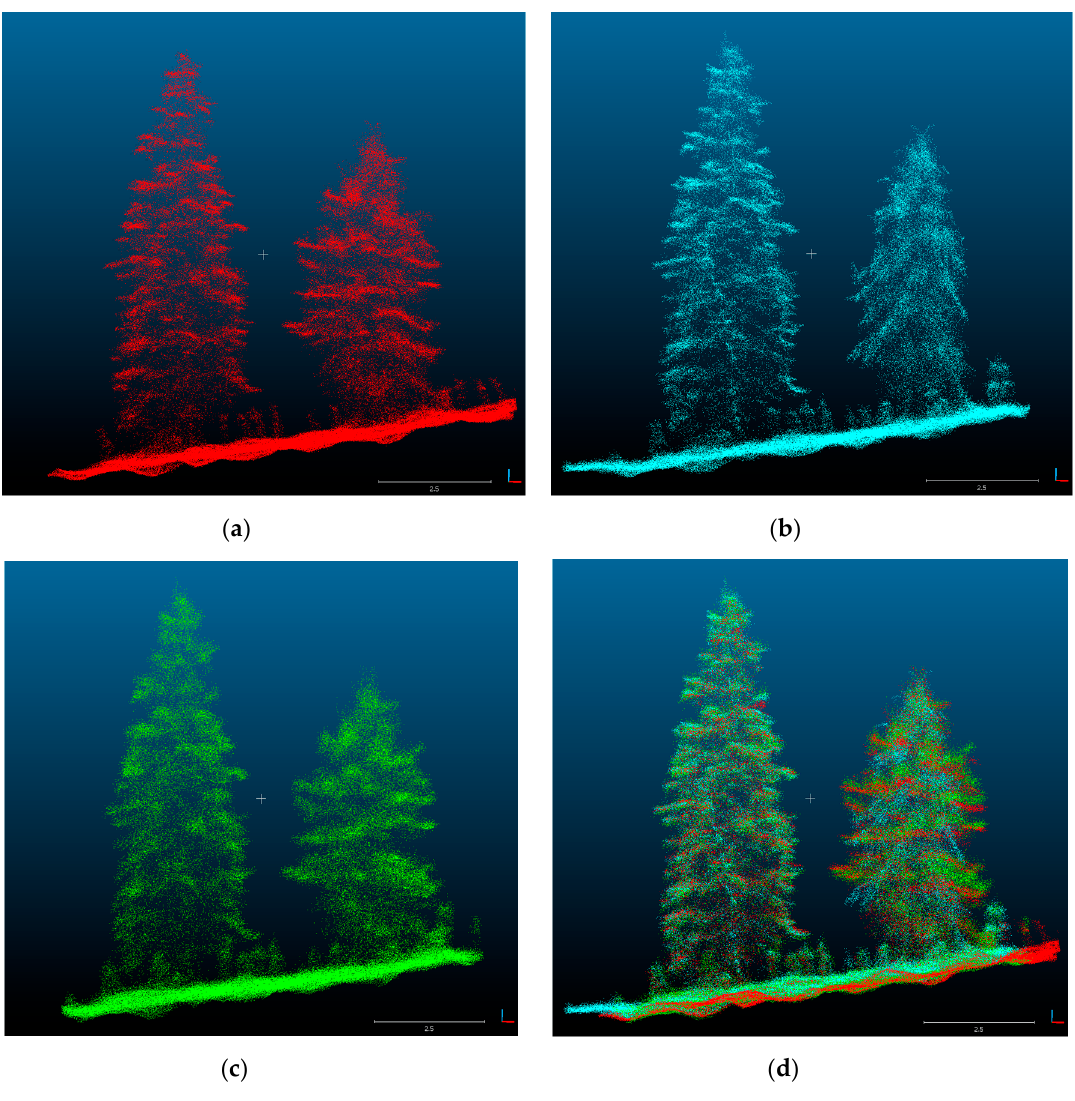
Figure 5. Examples of individual tree point clouds for tree 265 (on the left) and tree 273 (on the right).